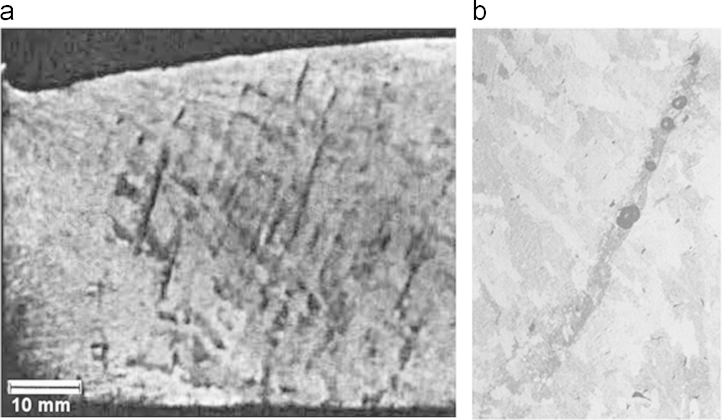
Channel segregation of horizontally solidified (a) Al-5.5 wt.%Cu [31] and (b) Al-20 wt.%Cu [30].